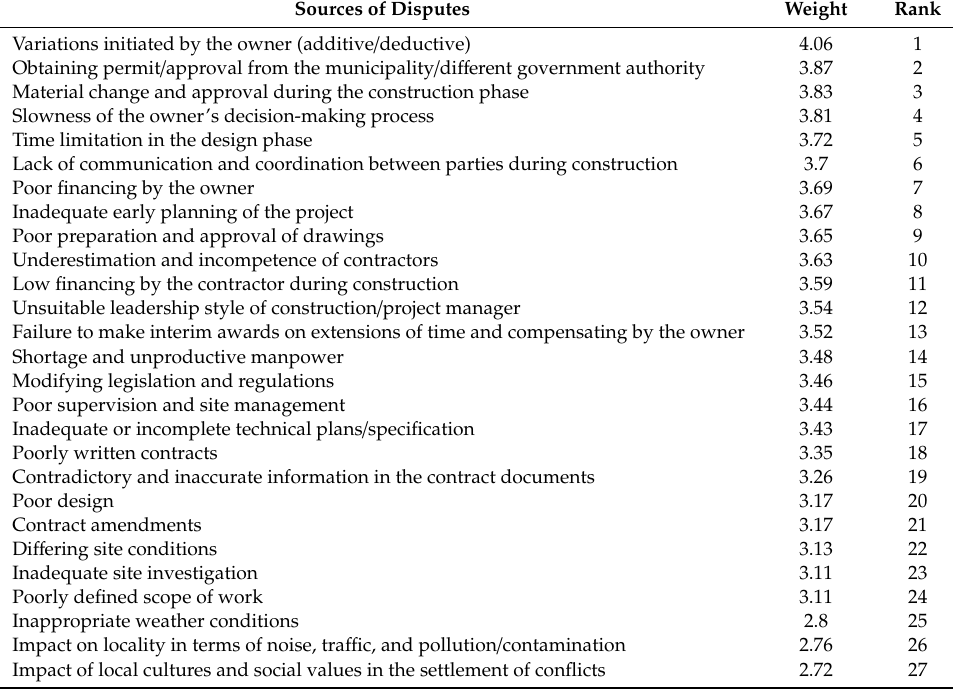
Table 4. Main construction disputes in the United Arab Emirates